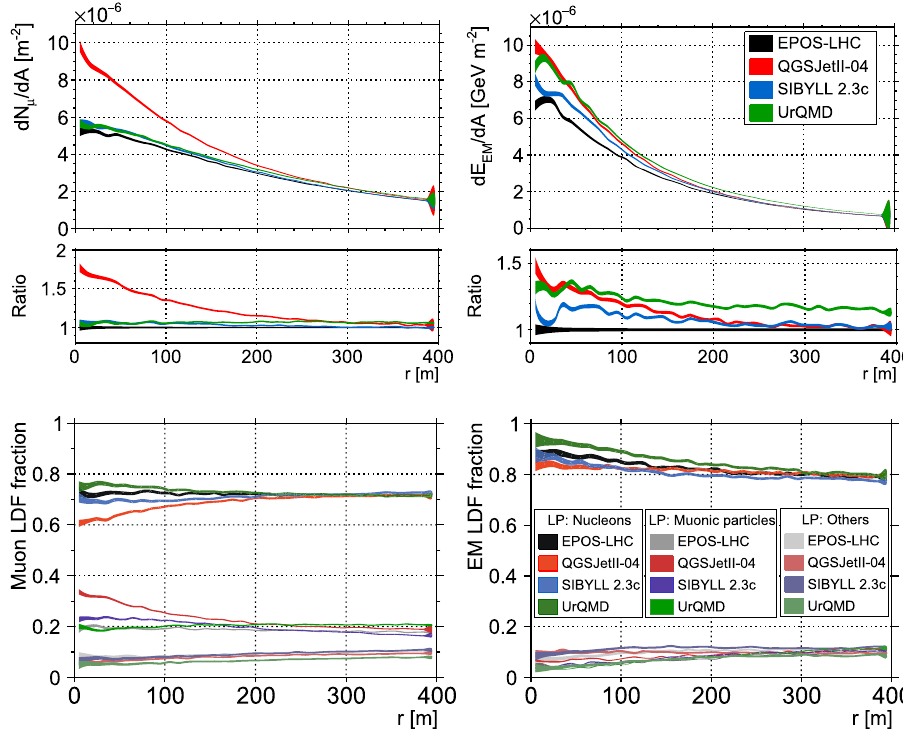
Fig. 9 (Top left panel) Average muon LDFs for the four hadronic interaction models at ground level (4100 m). (Bottom left panel) The LDFs ratios with respect to EPOS-LHC. (Right panels) Analogous to the left panels but for the energy deposit in the EM particles at ground level